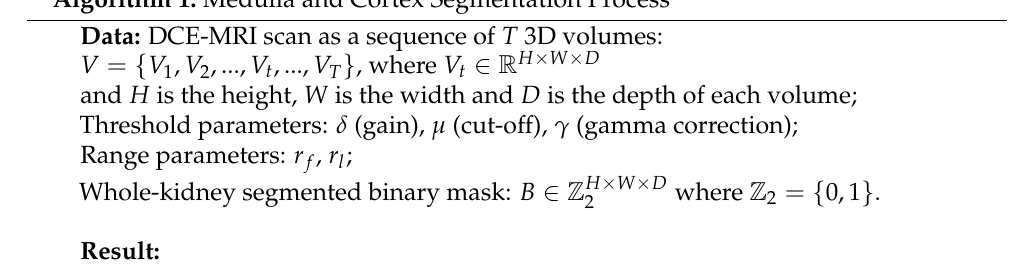
Figure 2. Overview of the proposed automatic renal segmentation approach. Using the input 4D DCE-MRI series, Process 1 detects the individual left and right kidneys (if present) via the automatic kidney segmentation approach. For each identified kidney, Process 2 performs medulla and cortex segmentation for all 3D volumes in the 4D DCE-MRI series. Process 3 generates the resulting single “optimum” volumetric medulla and cortex segmentation. Algorithm 1: Medulla and Cortex Segmentation